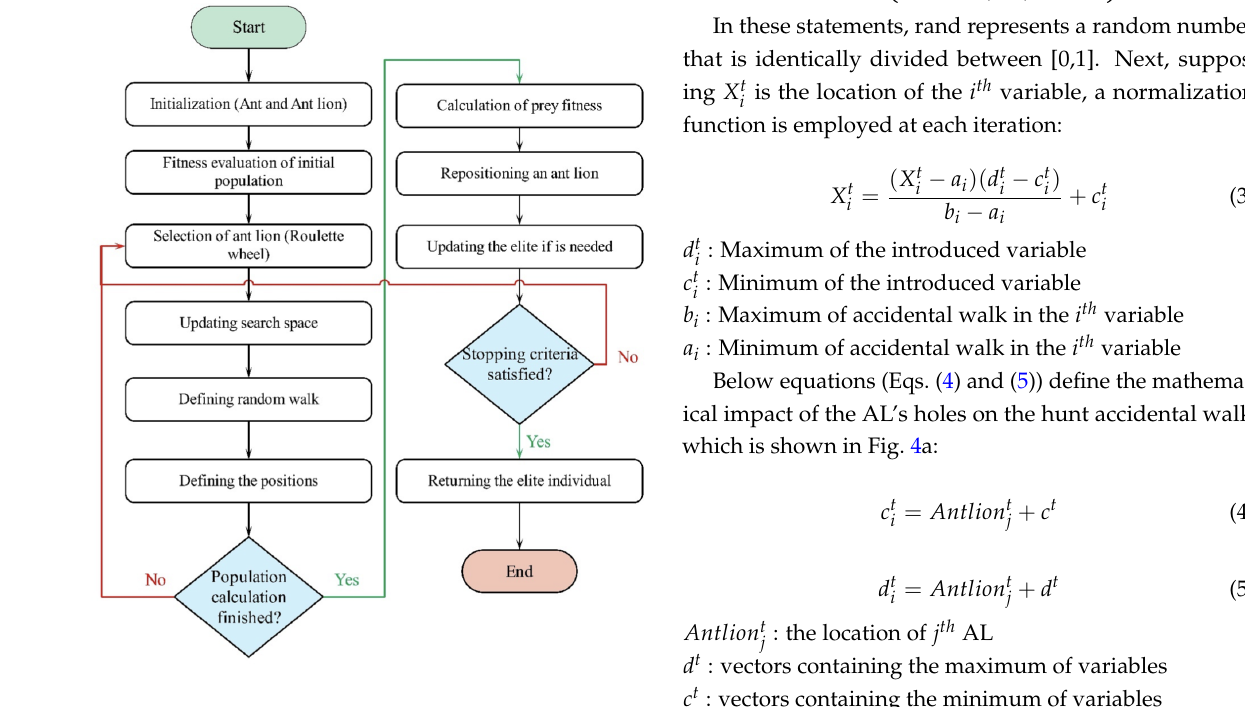
Fig. 3. The flowchart of the ALO